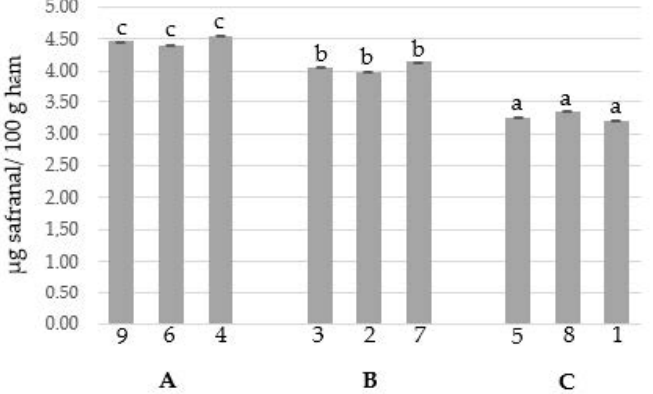
Figure 2. Mean values (3 × 2 n ) and standard deviation of safranal content of flavored cured ham samples (1–9) with different saffron ratios ( A : high, B : medium, and C : low).